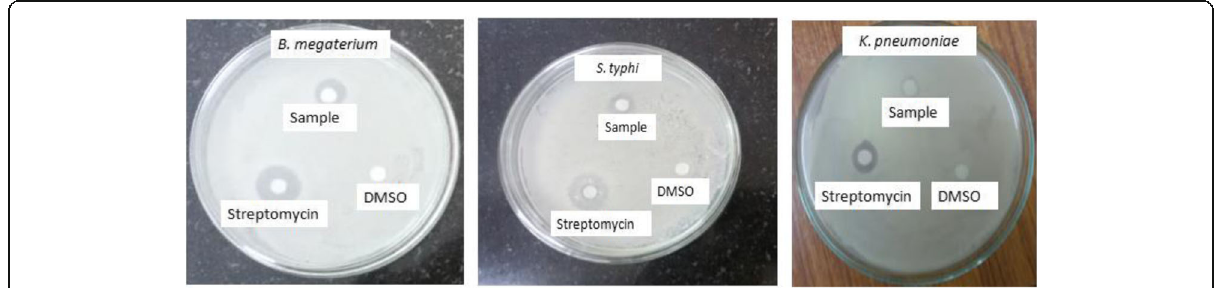
Fig. 2 Antibacterial activity of DMSO fraction of Pardosa brevivulva silk against B . megaterium , S . typhi , and K .